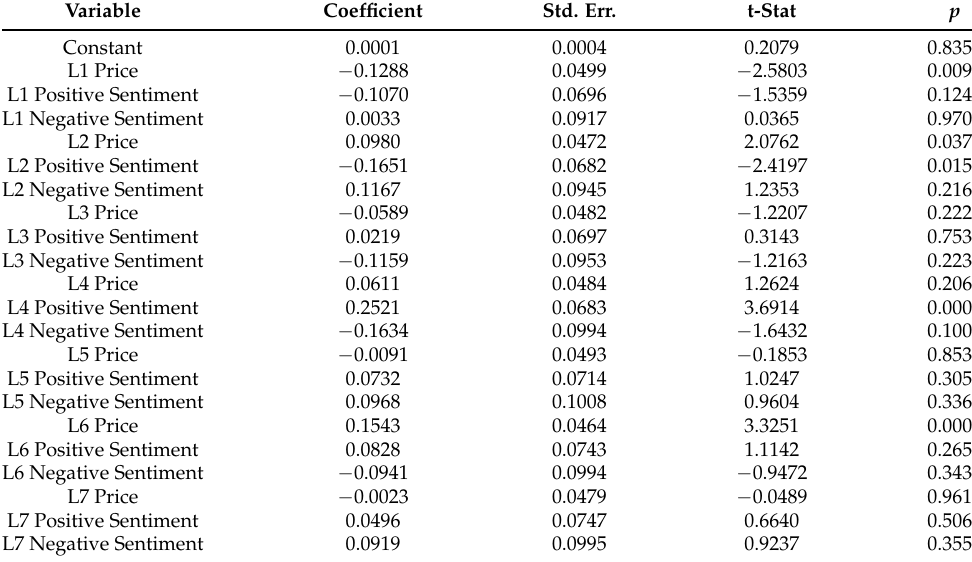
Table A3. VAR results for the regressions on aggregate negative sentiment. Optimal lag length was selected using a built in function in the VAR submodule of the statsmodels module in Python. Lx before a variable name denotes that a variable was lagged ×